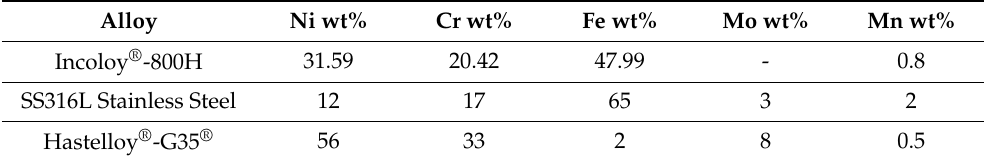
Table 1. Composition of the alloys used in this